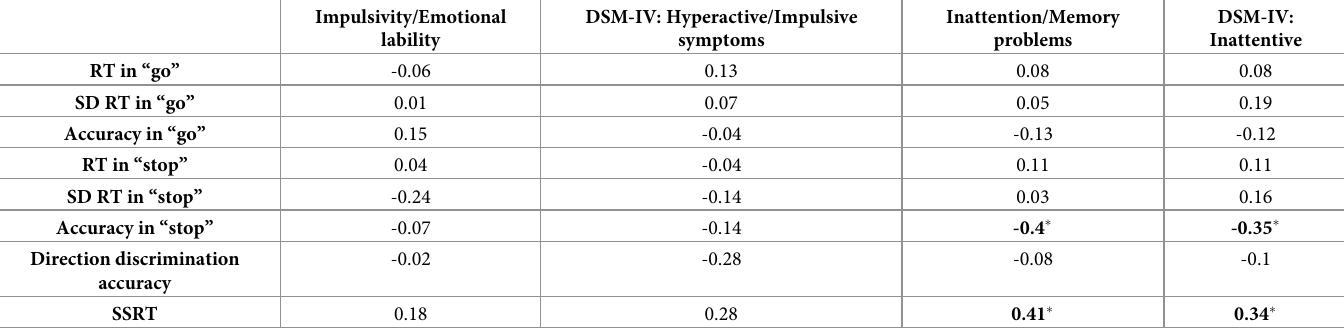
Table 4. Values of Spearman’s ρ for correlations between simple RT/ accuracy-based measures and impulsivity/inattention measures in mouse movement condition.